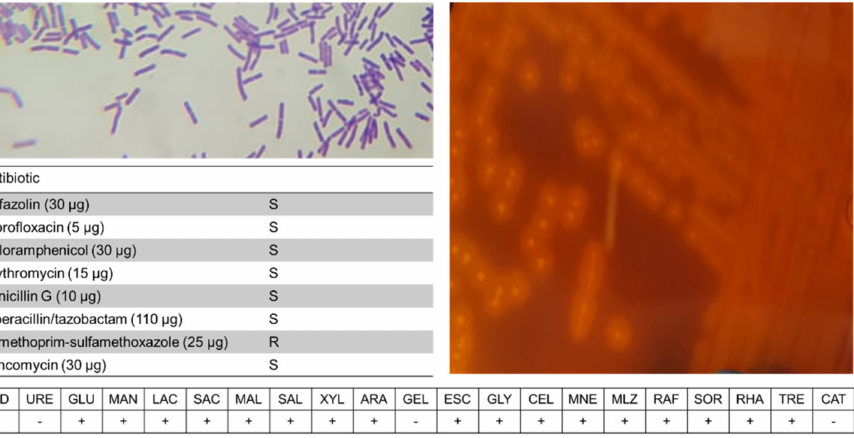
Figure 6. Phenotypical analysis of C. baratii C3. Shown are Gram-staining, blood agar analysis, disk diffusion, and API-20A